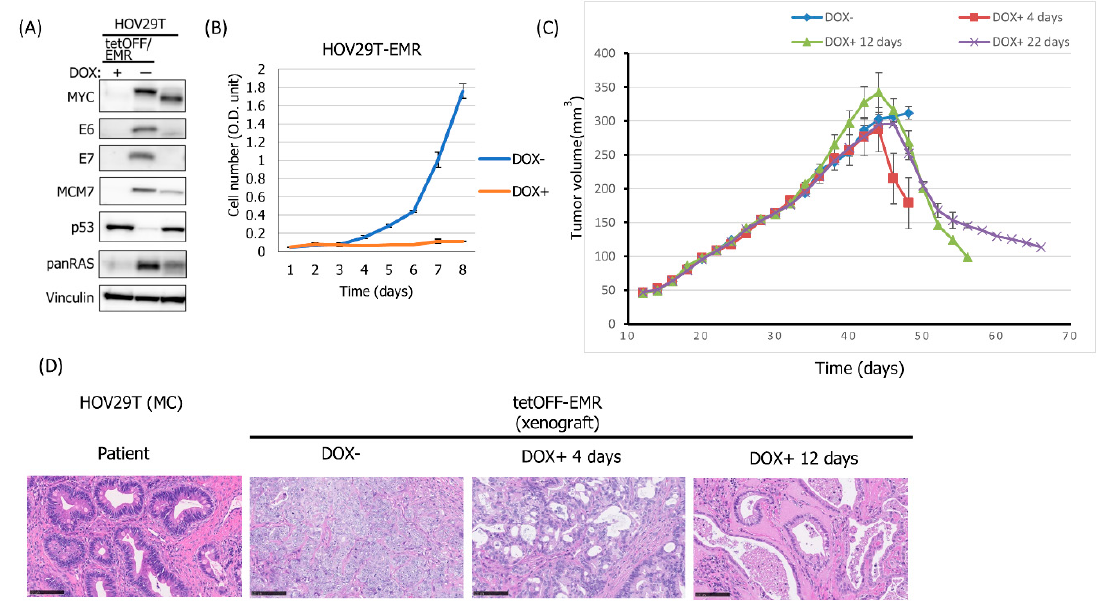
Figure 3. Generation of tumors and recapitulation of original tumor tissues by temporal expression of additional oncogenes in MC type HOV line. ( A ) Expression of the transgenes and their surrogate markers as well as vinculin as a loading control were detected by western blotting. ( B ) Cell growth curves of HOV29T/tetOFF/EMR cells with or without DOX. Each point is the mean of the triplicates ± SEM. ( C ) In vivo tumor generation capability of HOV29T/tetOFF/EMR cells. Cells were subcutaneously injected into nude mice. At day 44 when the average volume of tumors injected at 4 sites per mouse reached 300mm3, three mice were fed with drinking water supplemented with DOX (1 mg/mL) and sacrificed at 4 days (red), 12 days (green) and 22 days (purple) post-administration. Each point is the mean of the tumor volume ± SEM (n = 4). (D) Histopathology of HOV29T/tetOFF/EMR xenograft and original tumor of HOV29T, H&E. Scale bar 100 μ m